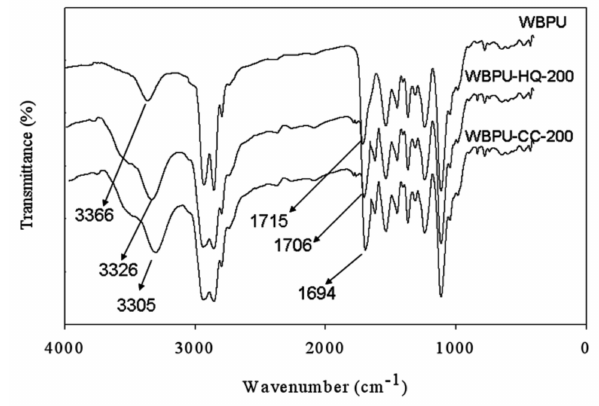
Figure 2. FT-IR spectra of